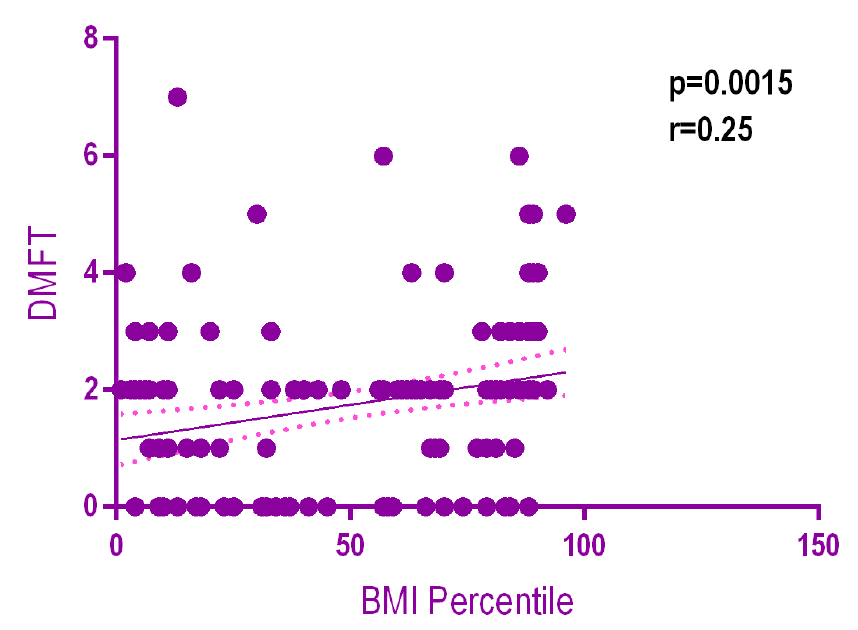
Figure 6. Relationship between the DMFT and BMI percentile.